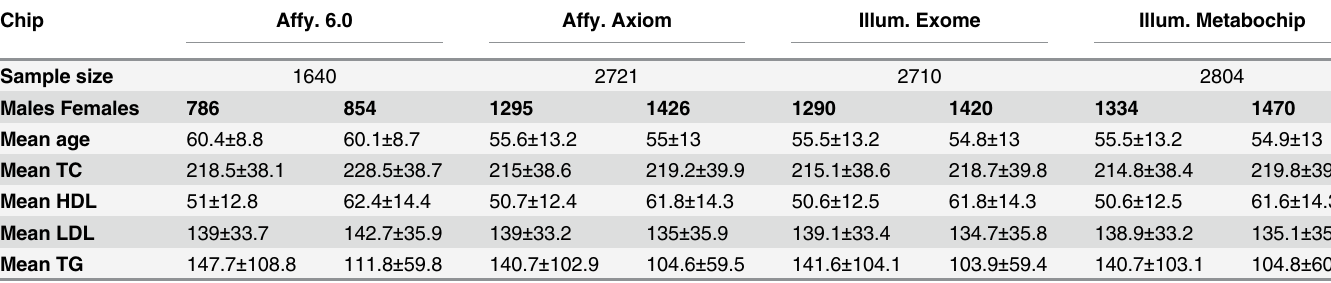
Table 1. Distribution of characteristics of the study population.